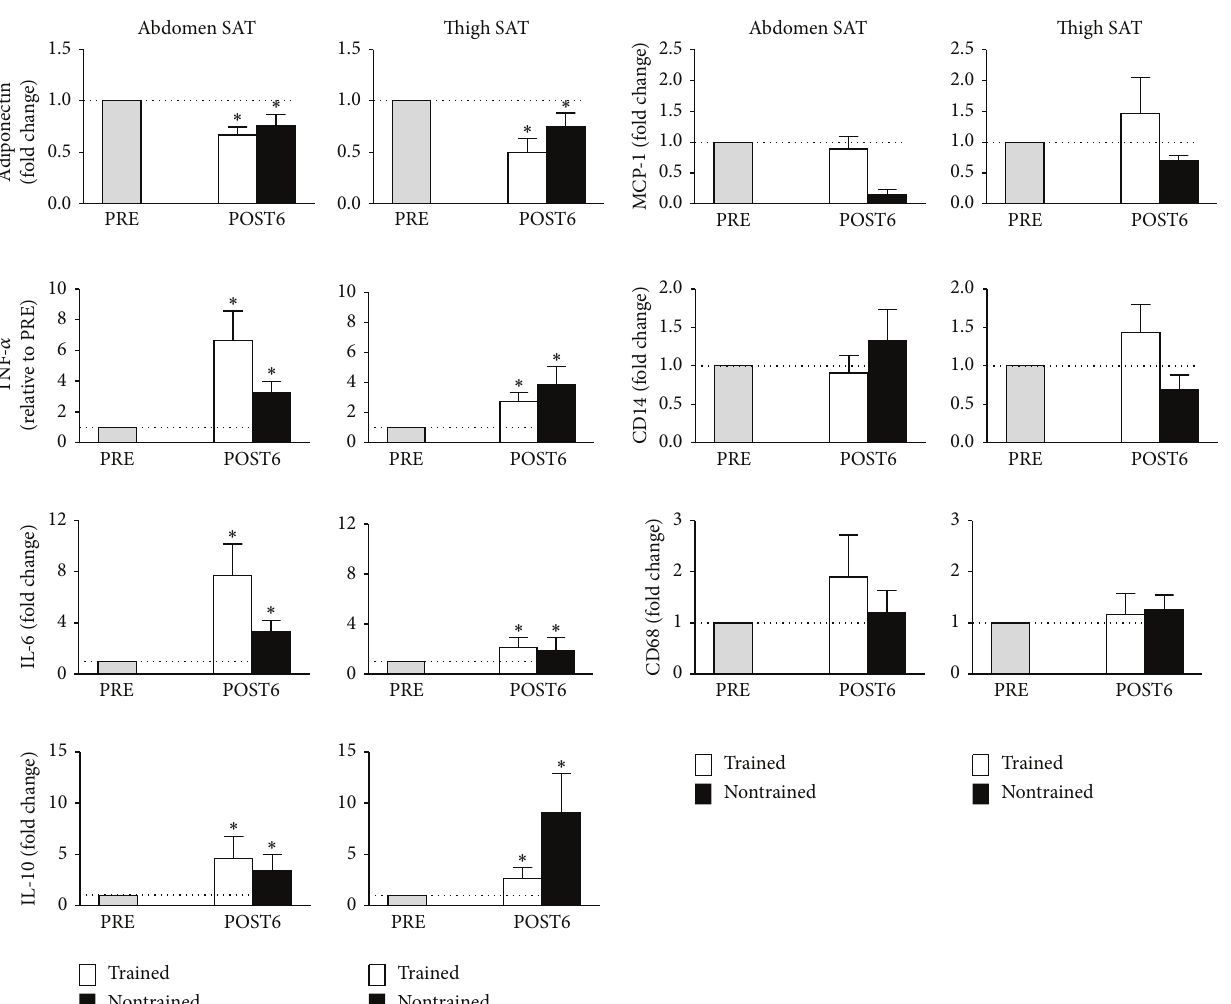
Figure 1: Subcutaneous abdominal and thigh gene expression of adiponectin, IL-6, IL-10, TNF- 𝛼 , MCP-1, CD68, and e CD64. Data are expressed as means and standard deviation of fold change at POST6 with levels at PRE for both groups arbitrarily set to 1. ∗ indicates main effects for time (PRE versus